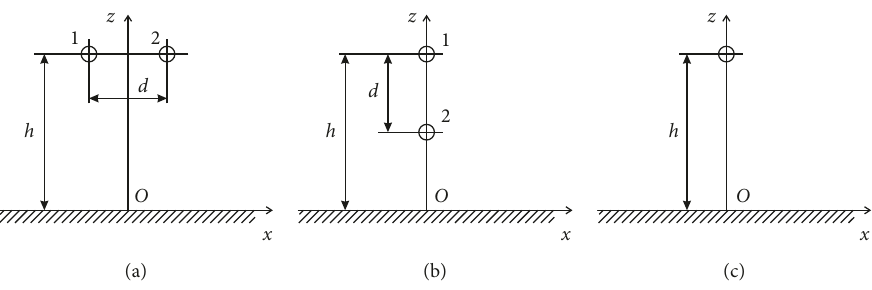
Figure 1: Dipole array structure: (a) one-level array (BSA); (b) two-level array (EFA); (c) single